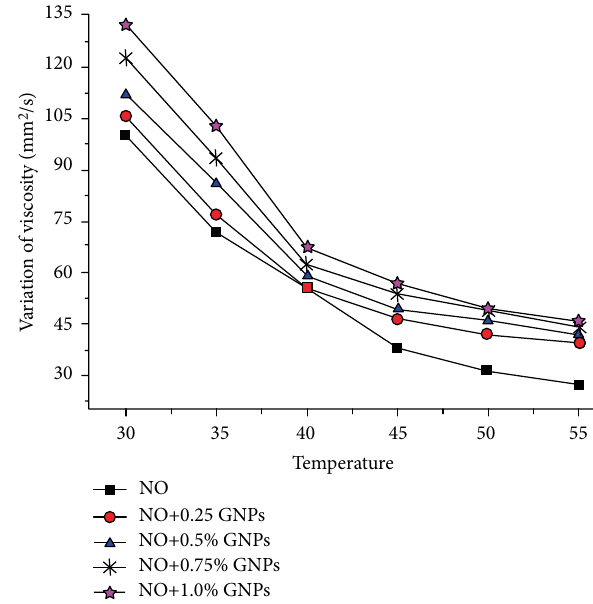
Figure 6: Kinematic viscosity of GNPs-neem nano-lubricants.